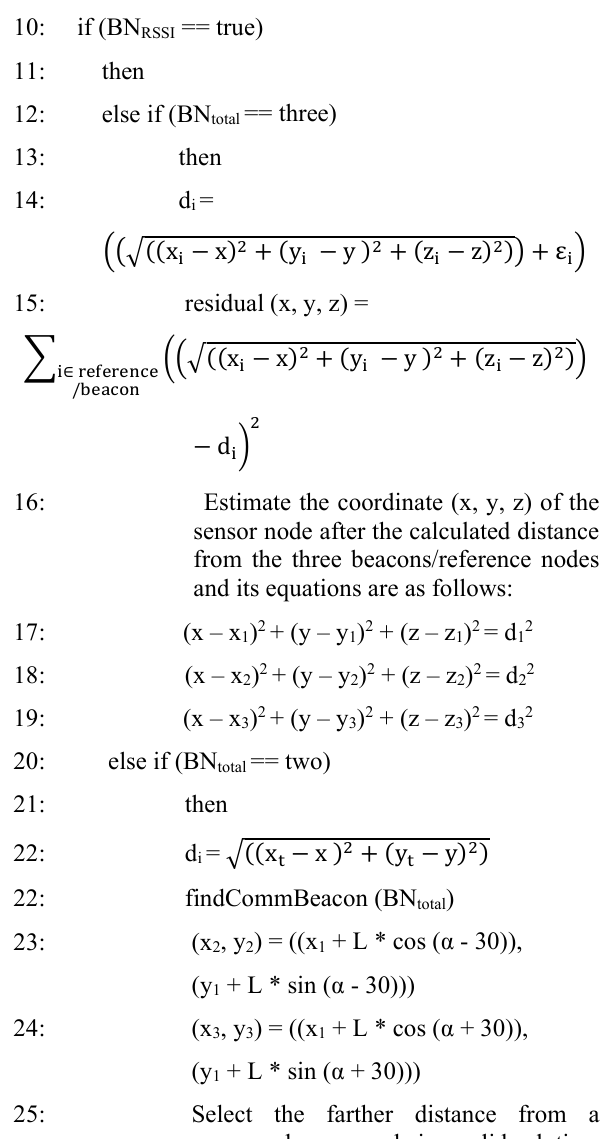
two beacons-based localization